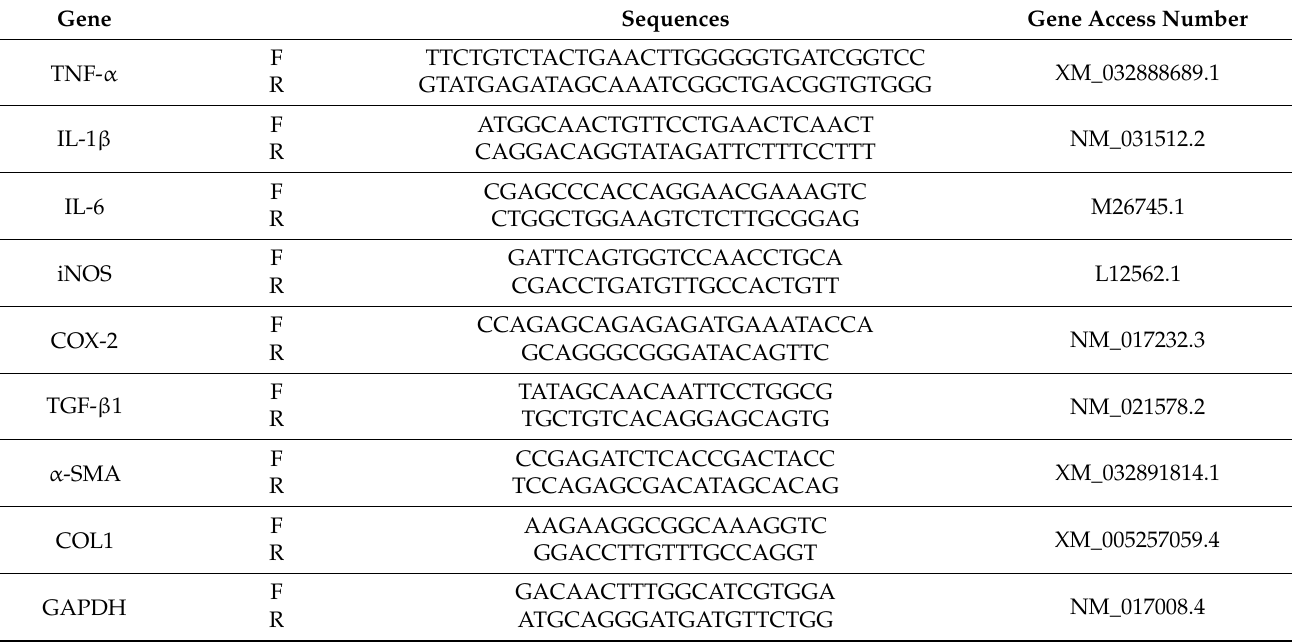
Table 1. Oligonucleotide sequences used in RT-PCR